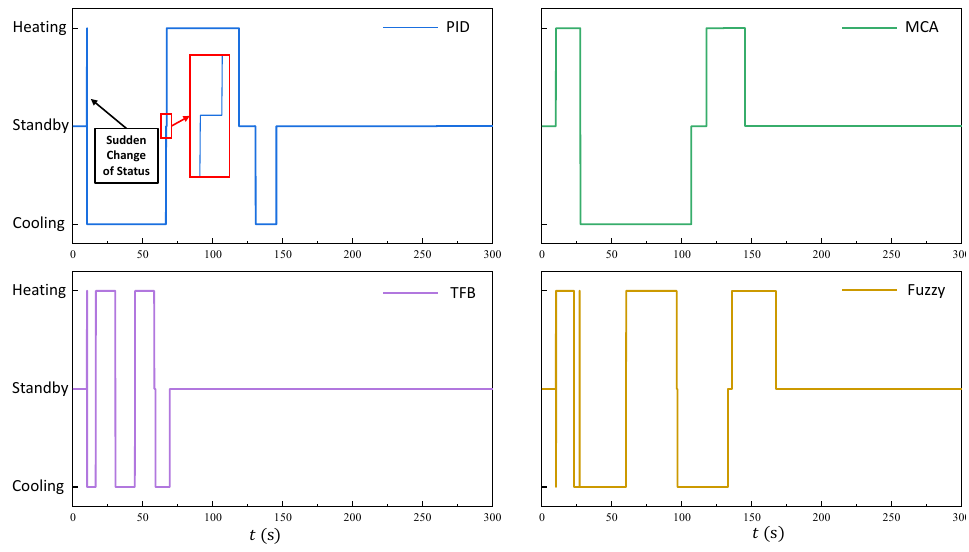
Figure 9. Ethanol thermostat working